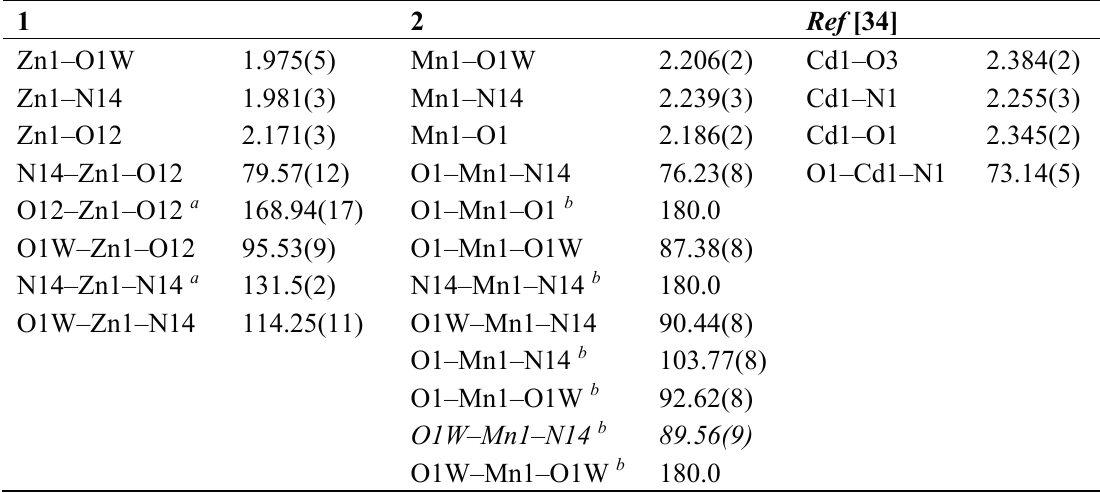
Table 1. Selected bond lengths (Å) and angles (°) for the metal coordination centers of mononuclear complexes [Zn(Hatrc) 2 (H 2 O)] ( 1 ), [Mn(Hatrc) 2 (H 2 O) 2 ]·2H 2 O ( 2 ) and, for